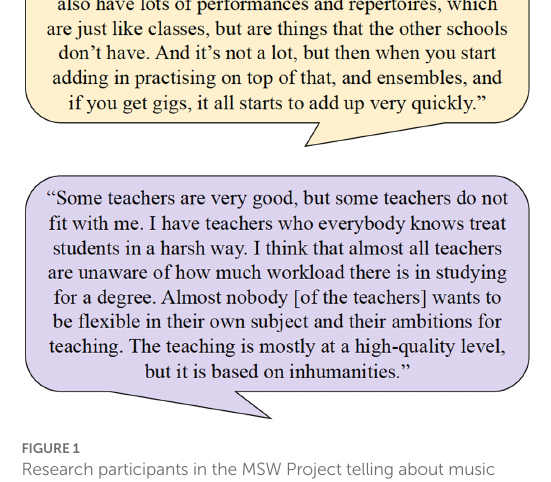
FIGURE 1 Research participants in the MSW Project telling about music students’ experienced